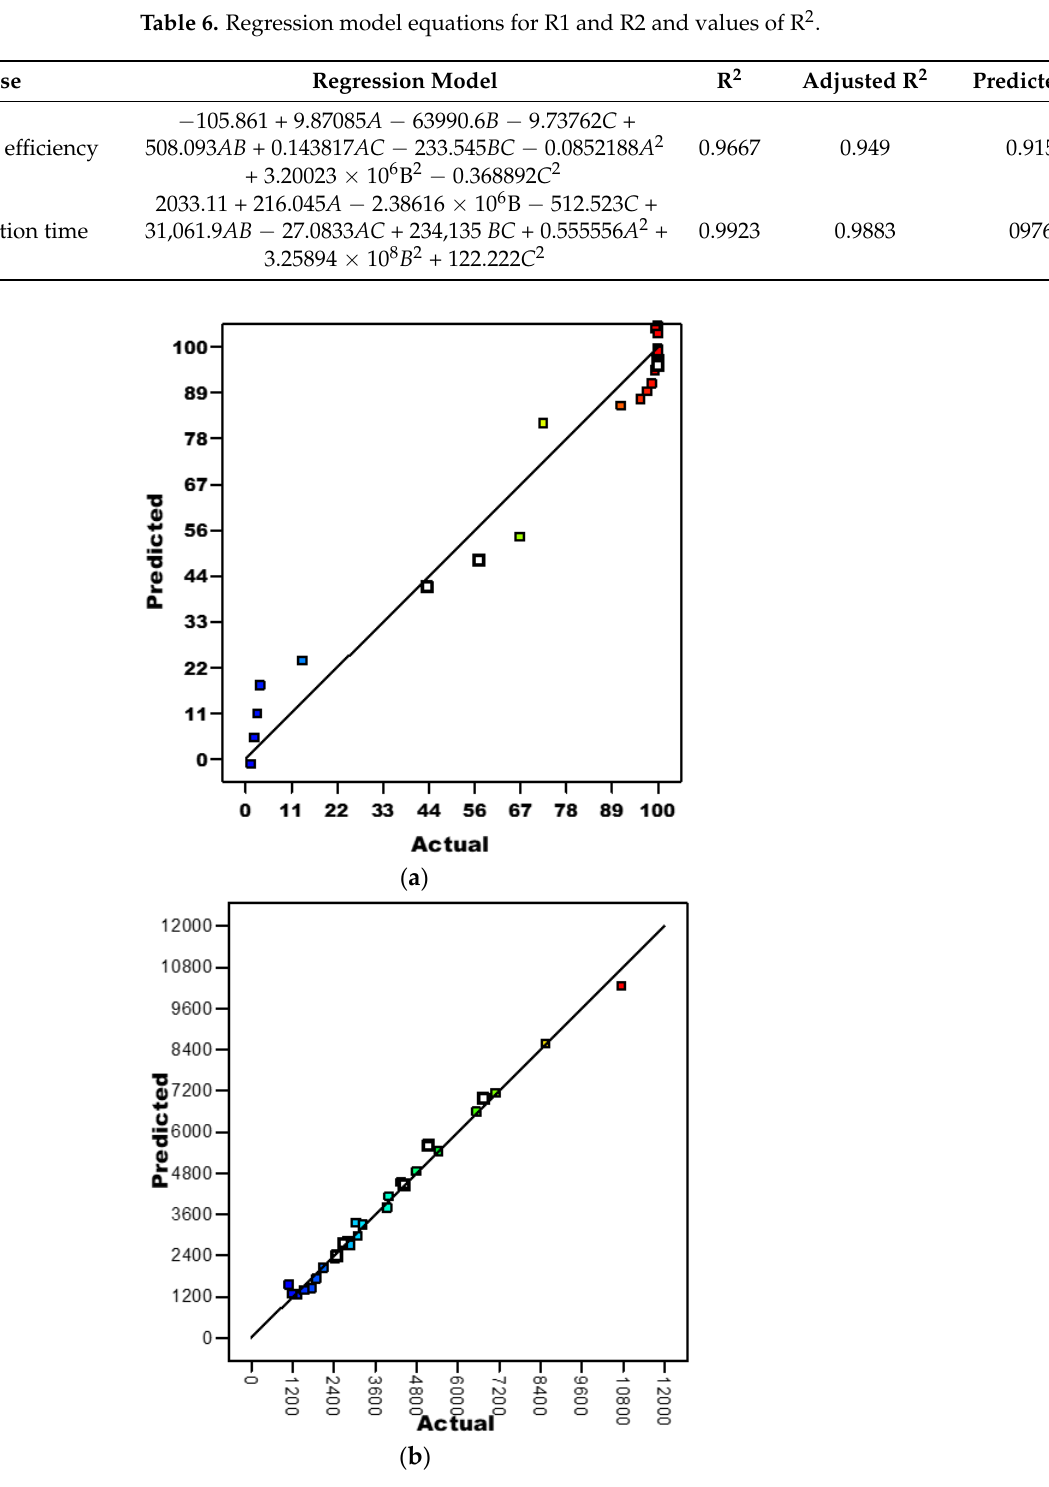
Table 6. Regression model equations for R1 and R2 and values of R 2 .